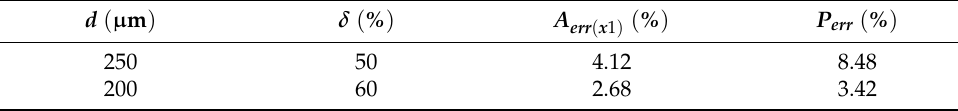
Table 3. Reconstruction errors of